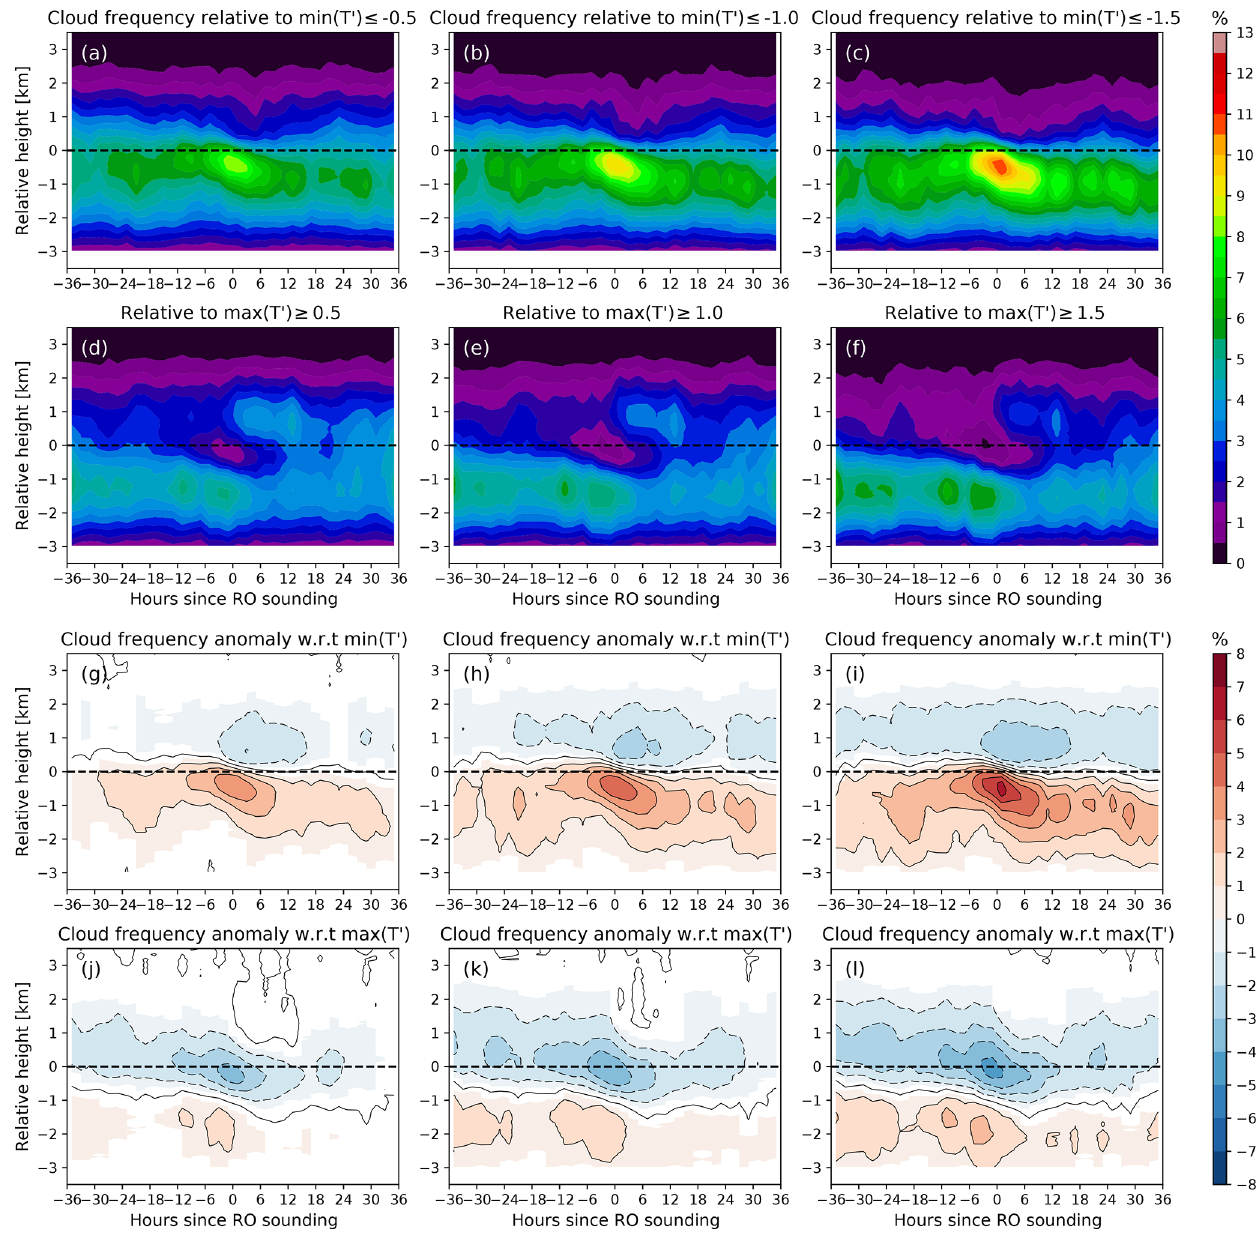
Figure 9. Composite of cloud frequency with respect to local minima (first row; panels a–c ) or maxima (second row; panels d–f ) of T (cid:48) . The columns correspond to composites made from subsets of T (cid:48) extrema with magnitudes greater than or equal to 0.5K (left column), 1.0K (middle), and 1.5K (right). Dashed horizontal lines indicate the position of the local T (cid:48) extrema. The third row (g–i) and fourth row (j–l) are the cloud frequency anomalies associated with cold or warm anomalies, respectively. Contours in the bottom two rows are at intervals of 1% (dashed negative), matching the filled color contours which show values at or above the 95% significance level.